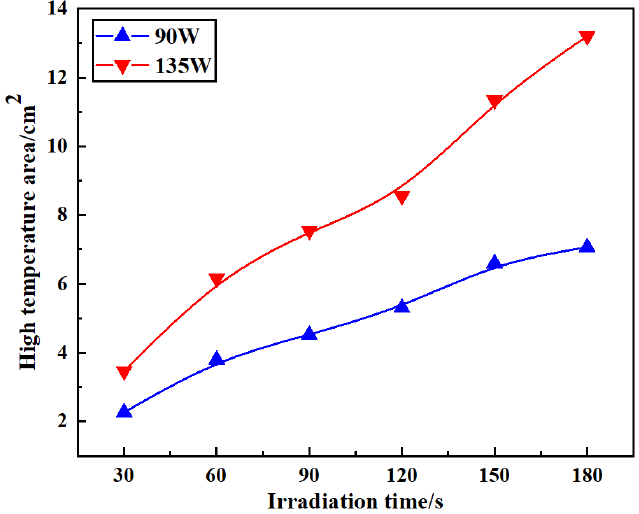
Figure 4. Variation of high temperature area with irradiation time.